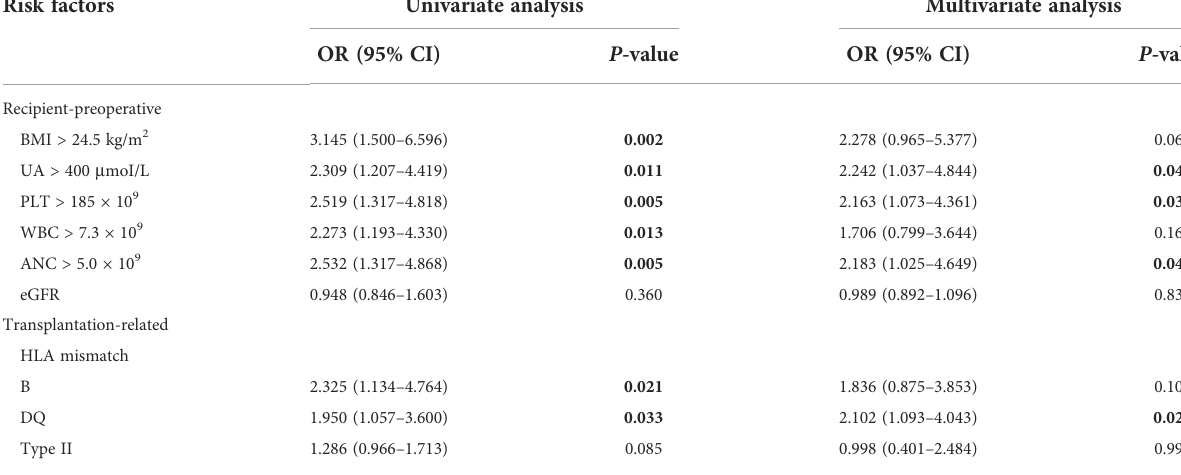
TABLE 4 Risk factors for treated rejection in univariate and multivariate